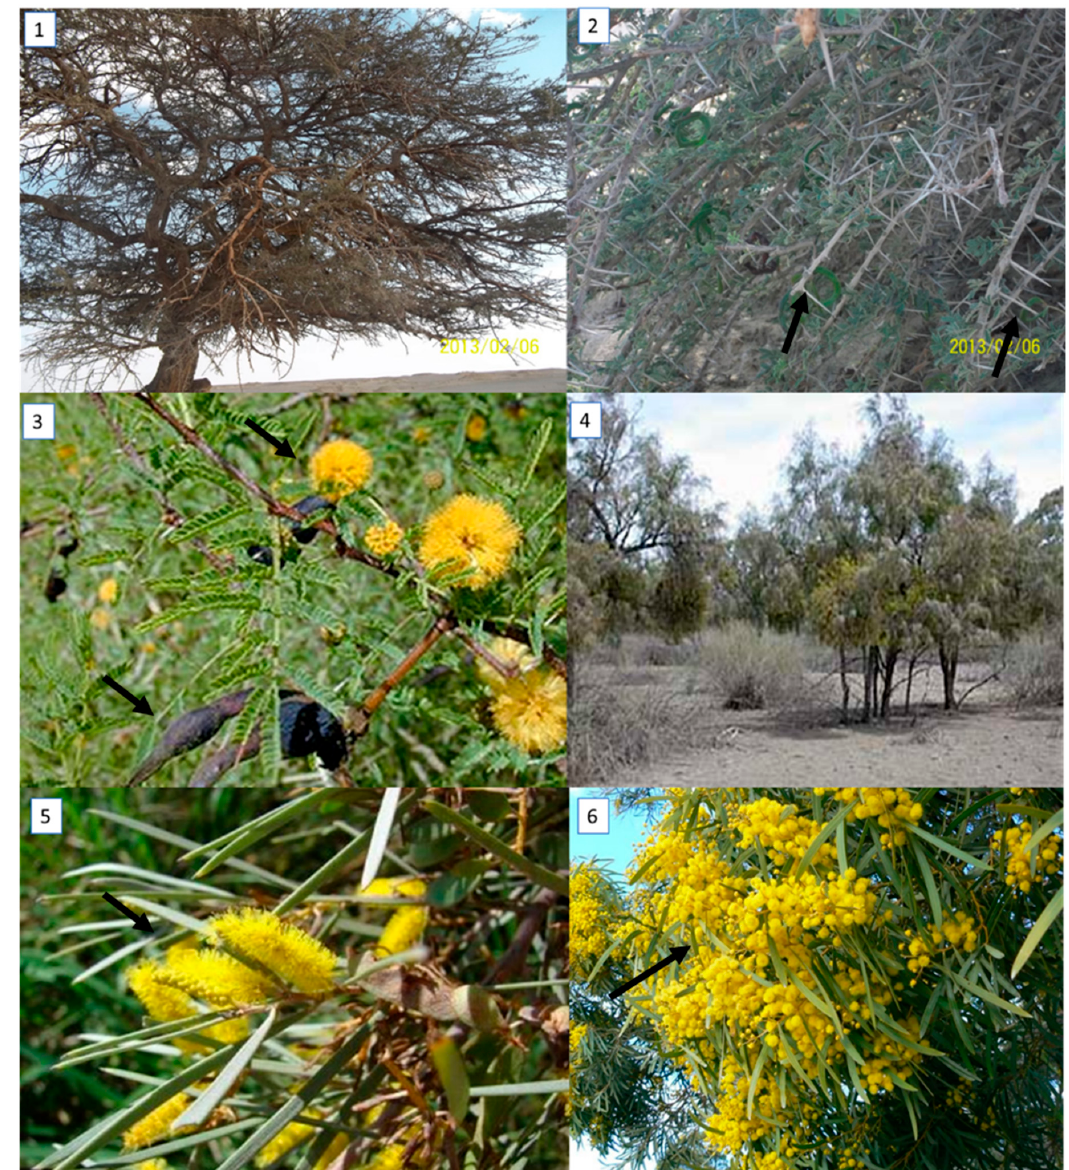
Figure 2. Morphological variations of Acacia species growing in Egypt, i.e., (1–2) A. tortilis ssp. raddiana (Borg Al-Arab, 48 km south-west of central Alexandria and 7 km Mediterranean Coast, 30 ◦ 50 (cid:48) 56 N 29 ◦ 36 (cid:48) 42 E), arrows point to the di ff erent pine and pinna and show the di ff erence in tree form and leaf length, pinna length and spine length, (3) A. stenophylla (Marsa Matroh City, 240 km west